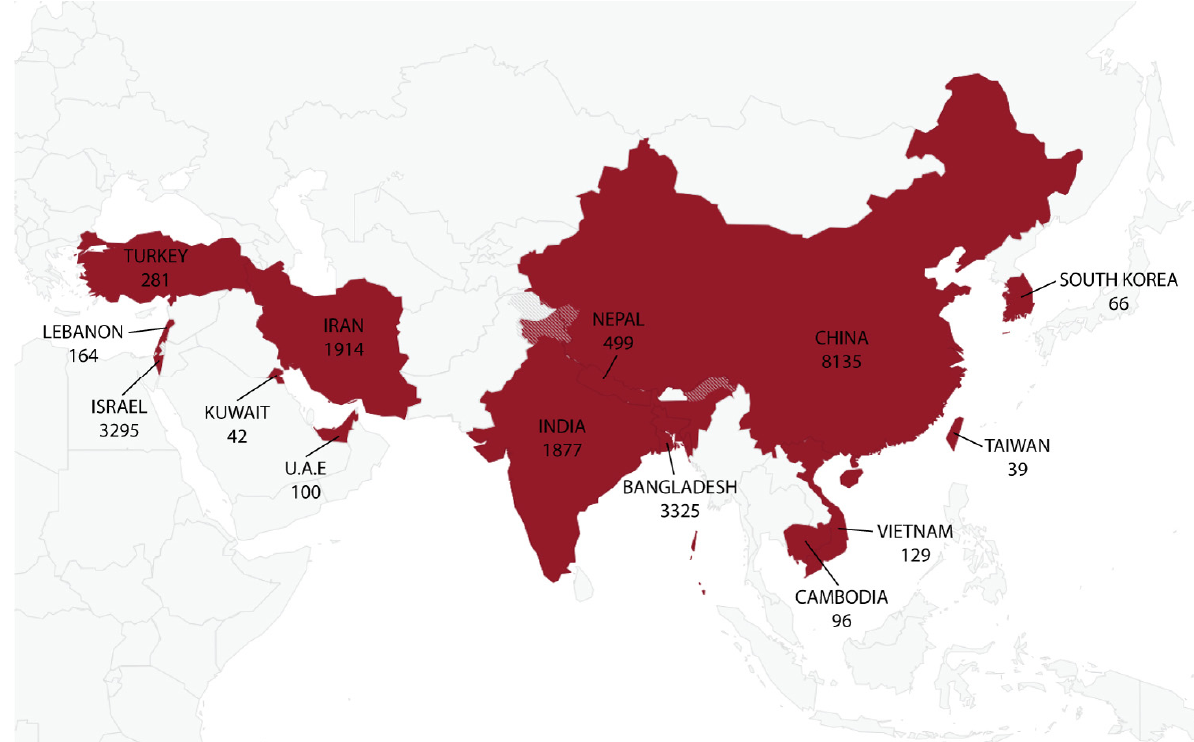
Figure 2. Distribution of Shigella spp. across 14 Asian regions from 63 studies. A total of 19,962 cases from the continent were identified involving Shigella spp., and China represented the country with the most cases of Shigella infections ( n = 8135), as reported in 15 different studies, whereas the lowest number of cases involving Shigella spp. was recorded for Kuwait ( n = 42) in a single study. Table 1. Major characteristics of the 63 studies included in this systematic review and meta-analysis (SRMA).